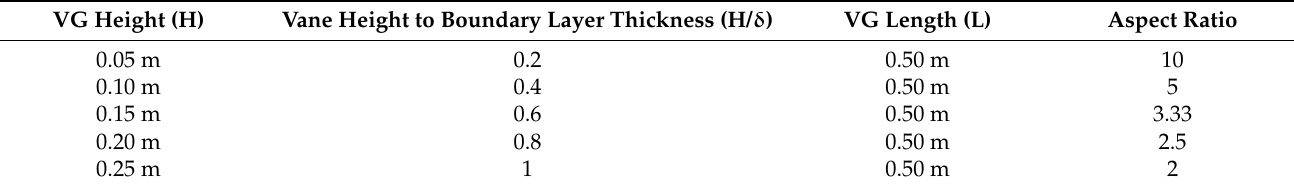
Table 1. Vortex Generator (VG)